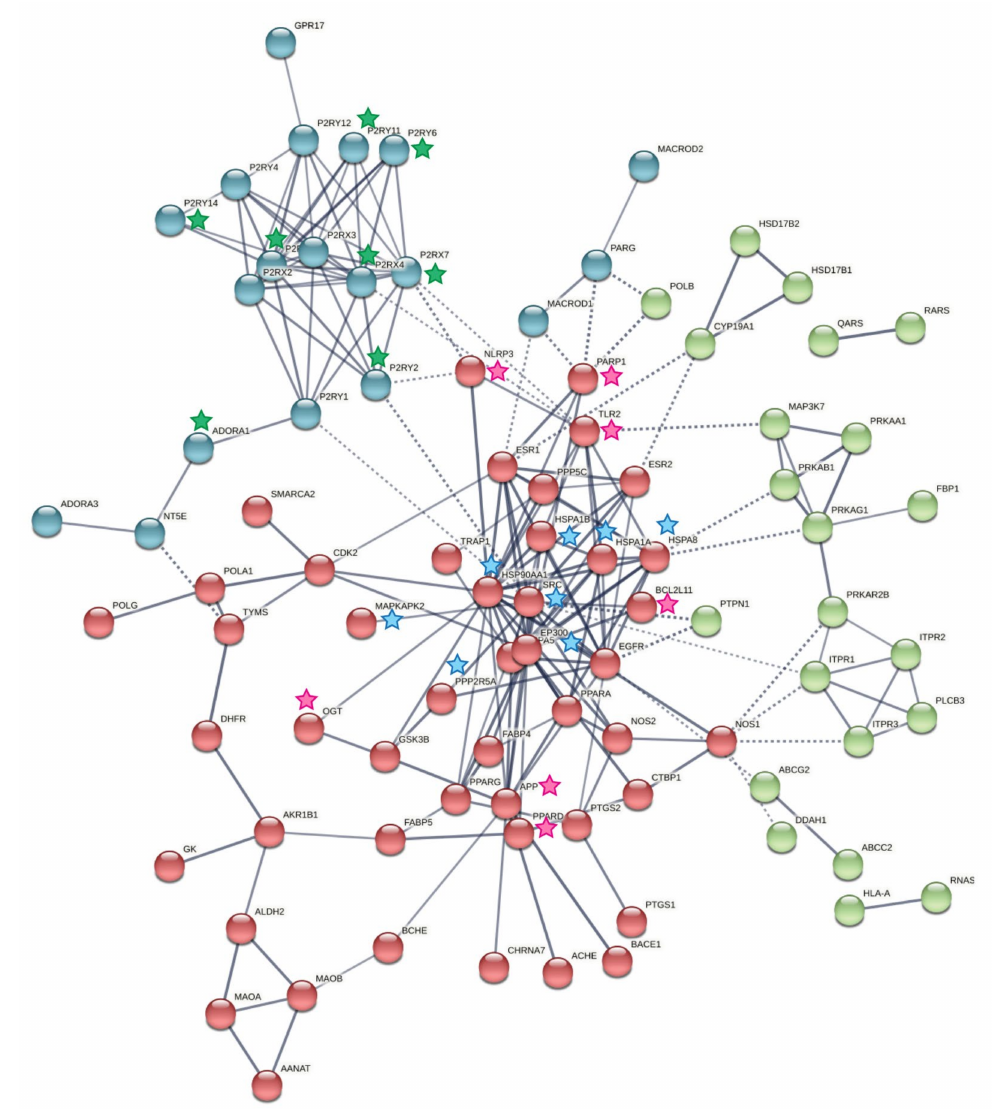
Figure 5. Interaction network map of protein targets of altered metabolites showing clustering of proteins into three groups. The edges connecting the nodes represent high confidence. Proteins associated with apoptosis and immune response are highlighted with pink and blue stars, respectively, while proteins associated with inflammation are highlighted with green